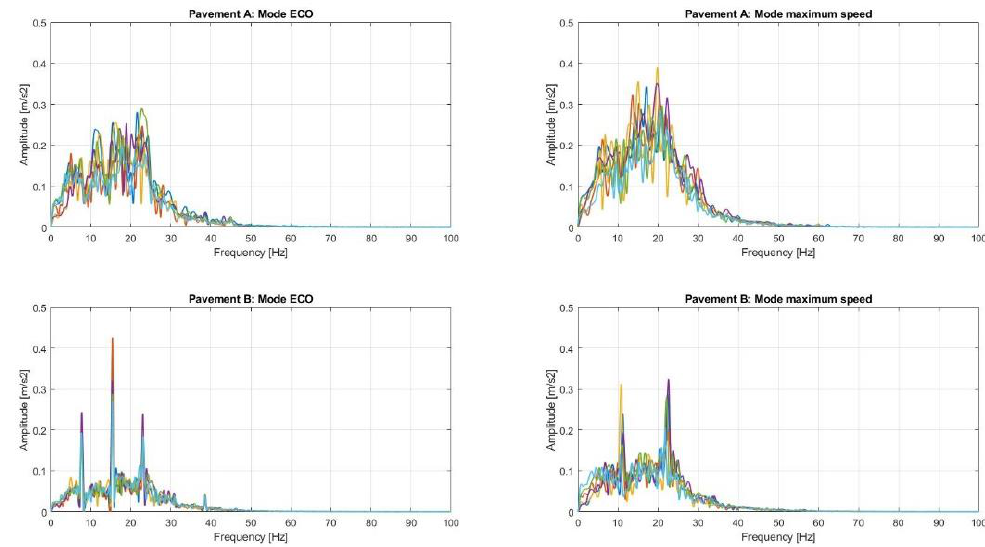
Figure 12. Frequency response analysis of vertical acceleration.